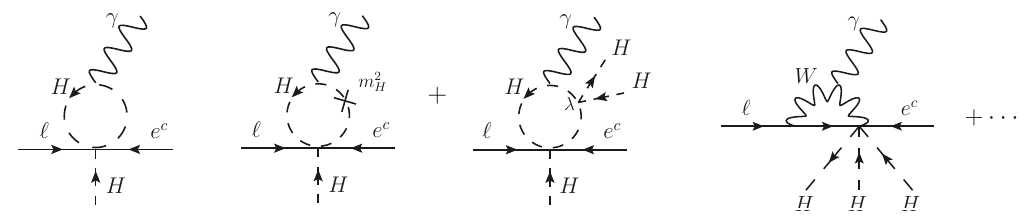
Figure 3 . Corrections to ( g − 2) µ from the dimension-eight operator in eq. (2.7) in the low energy effective theory after integrating out L and S . ( Left ) Naive quadratically divergent contribution to a dimension-six operator, which vanishes exactly in the full UV theory. ( Middle ) Corrections to dimension-six and eight operators, whose sum vanishes at the vacuum. ( Right ) Corrections to a dimension-eight operator that gives the dominant